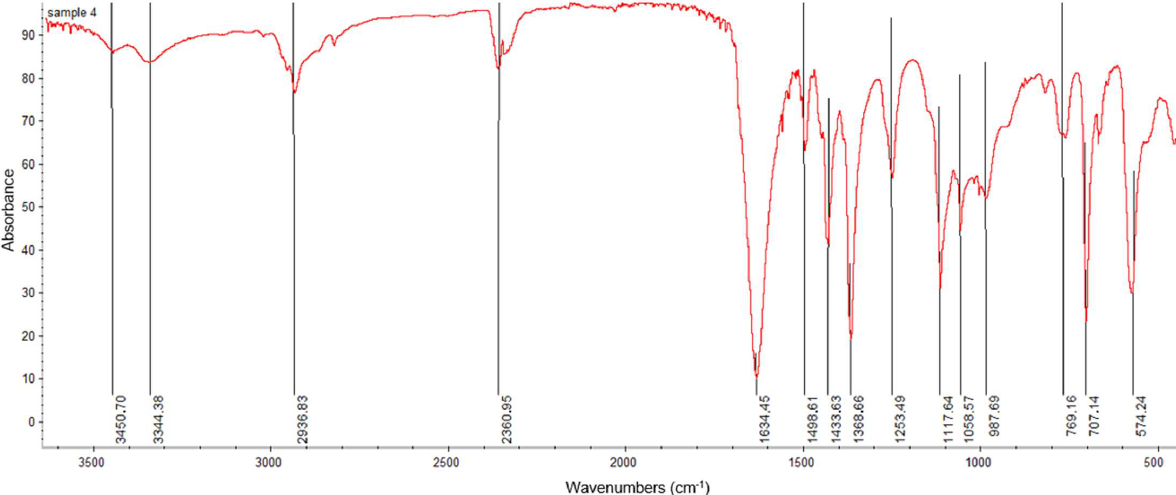
Figure 12. From top to bottom. IR spectra for 1 – 4.